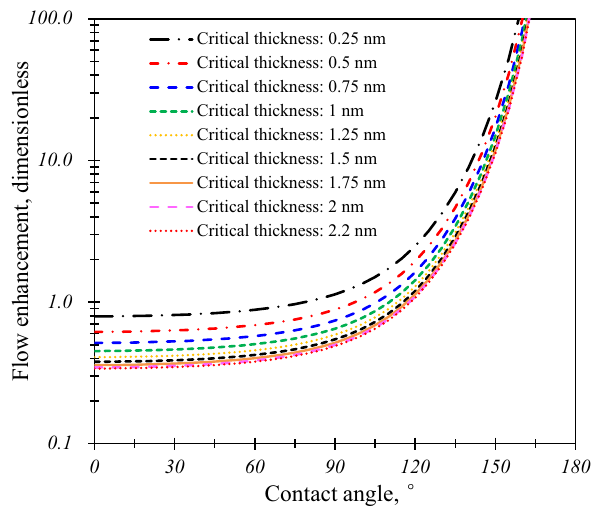
Fig. 3 Relationship between flow enhancement and contact angle under various critical thickness condition